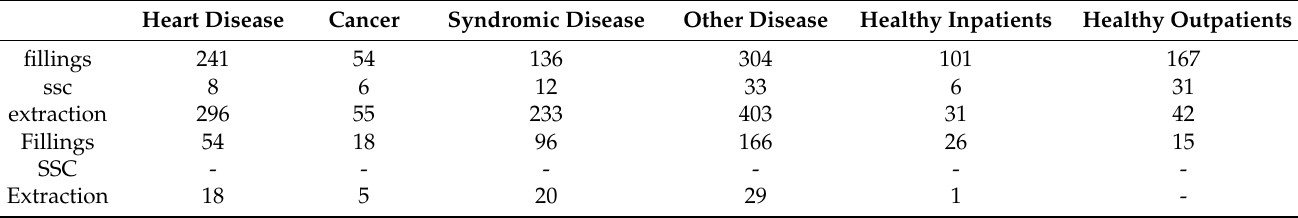
Table 3. Number of dental procedures in GA patients (lower case words for primary and capitalized words for permanent